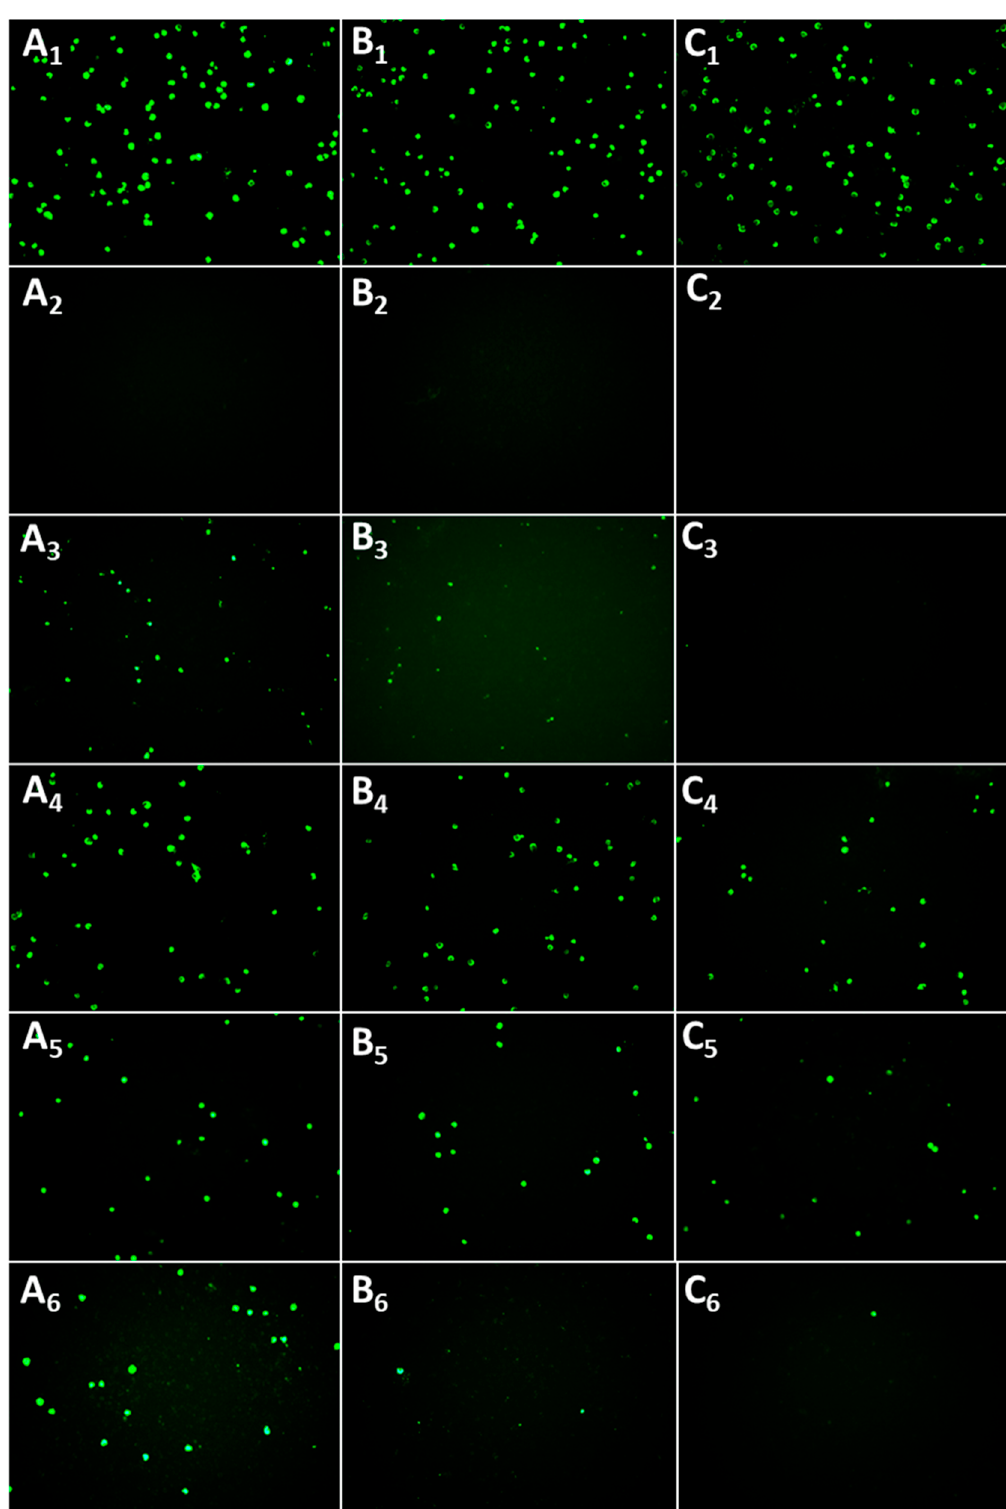
Figure 2. RES formulations reduce the number of C. trachomatis -infected cells. Two hours after McCoy cells were infected, the cells were left untreated or added treatment (RES concentrations of 1.5, 3 or 6 µg/mL for ( A – C ), respectively). The effect on bacterial survival was evaluated by staining of inclusions. The figure shows representative pictures of the antimicrobial effect of azithromycin (AZT) (2), free RES (control; RES in propylene glycol) (3), RES in hydrogel (4), RES liposomes (5) and RES liposomes-in-hydrogel (6), compared to the negative control (1) where no treatment was added. All pictures were taken with same magnification (10×).